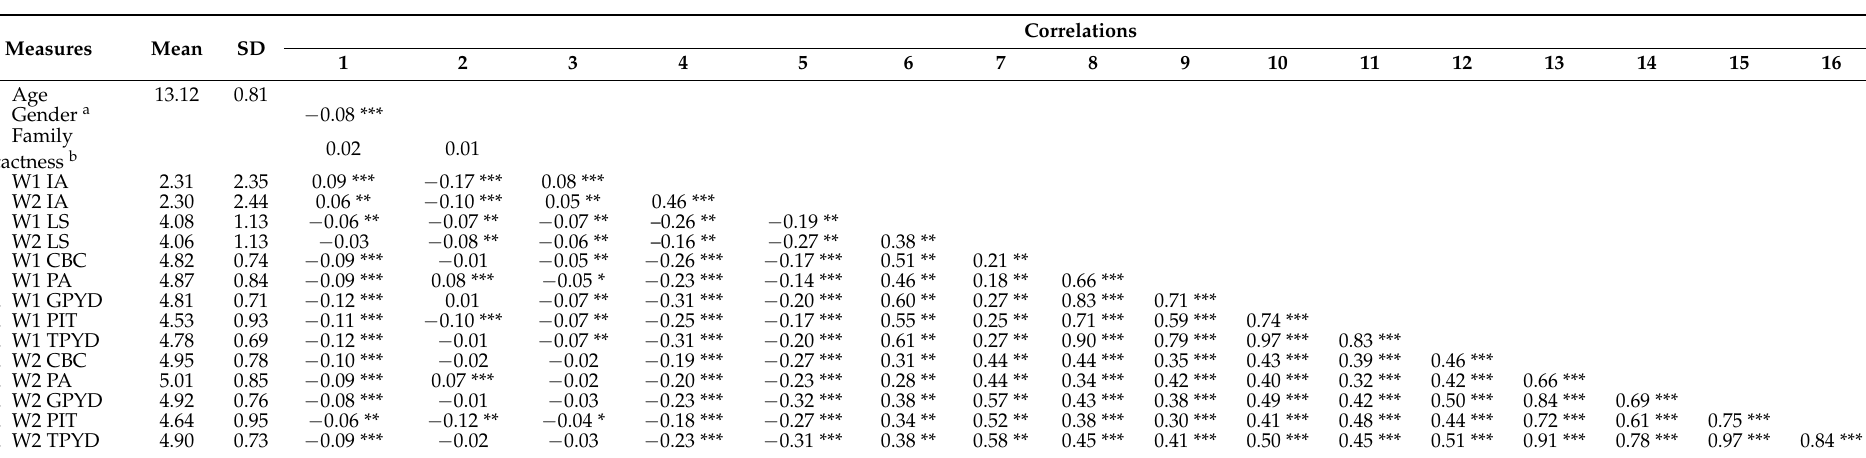
Table 2. Descriptive and correlational analyses.